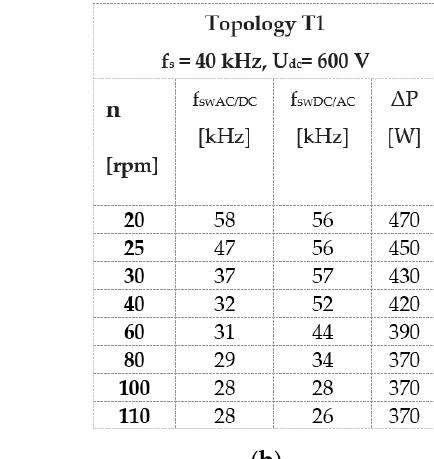
Figure 11. ( a ) Power losses in the topology T2 at different voltages in the DC circuit and ( b ) switching frequency of the grid converter transistors f sw and the generator converter pulse duty  at U dc = 600 V.